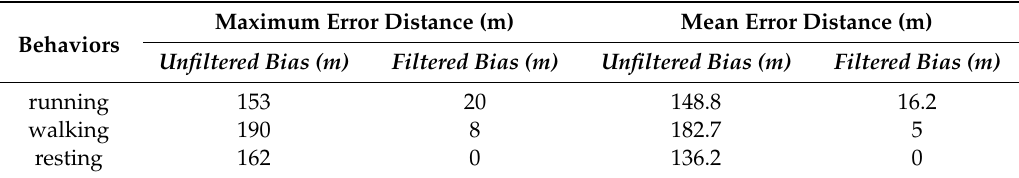
Table 5. Mean calculated errors (biases) in meters for GPS unfiltered and GPS filtered distances for all three goat’s behavior during seven-day